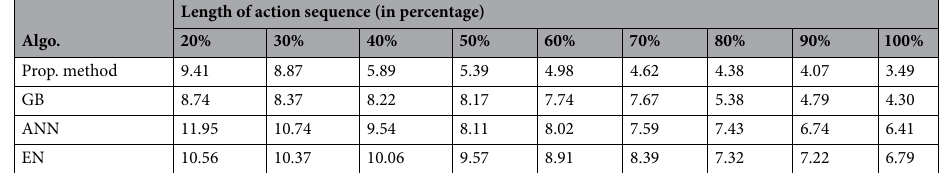
Table 6. Mean MAPE values (with training data during 10-fold cross validation with same random number seed) for different competitive methods for different length of action sequence (in percentage).